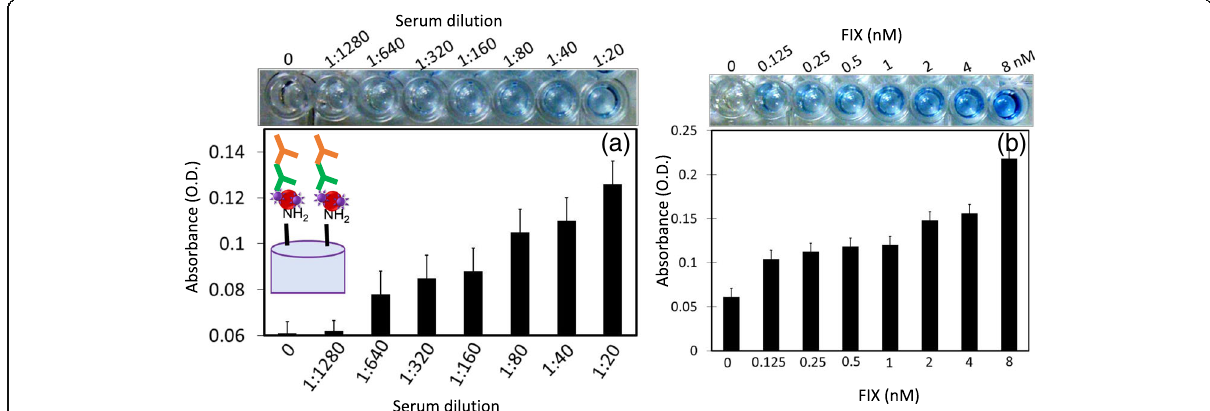
Fig. 6 a Detection of FIX in human serum. Human serum was diluted from 1:20 to 1:1280. FIX was detected in human serum diluted 1:640 (figure inside indicates the schematic representation). b Spiking of FIX (0.125 to 8 nM) into 1:640 dilution of human serum. With increments in the FIX concentration, the absorbance was increased. Figure insets display the visual results